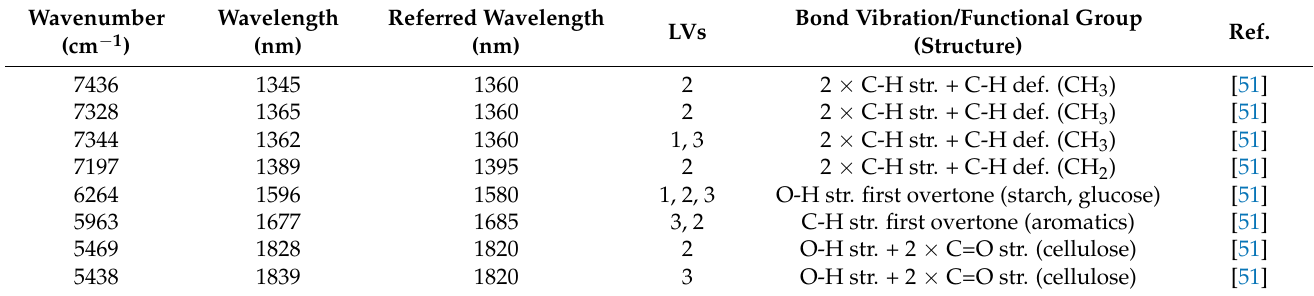
Table 9. The bands with a high X-loading weight of the PLSR model for TSS in mango pur é e.